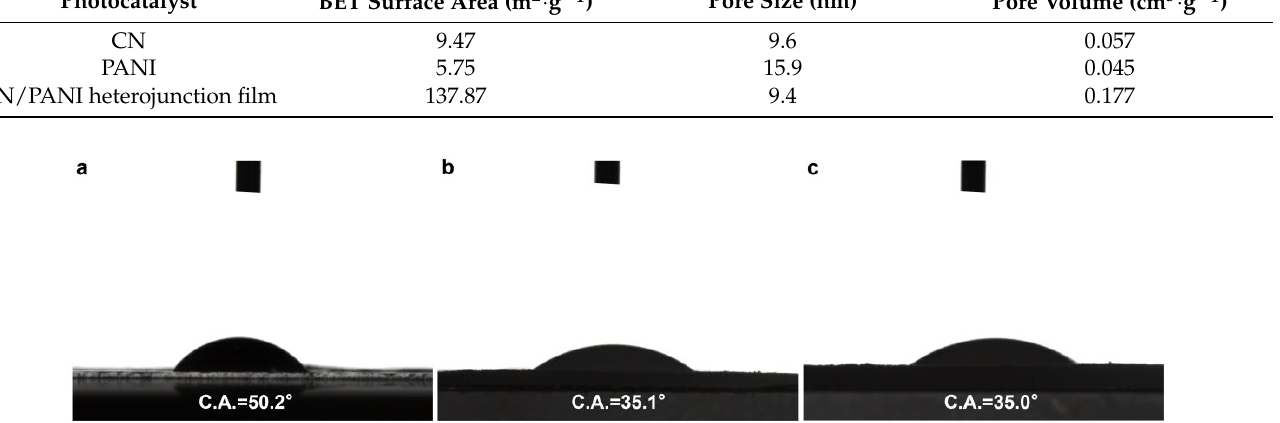
Figure 6. Water-droplet contact angles of ( a ) the pristine CN, ( b ) bare PANI, and ( c ) CN/PANI heterojunction film.